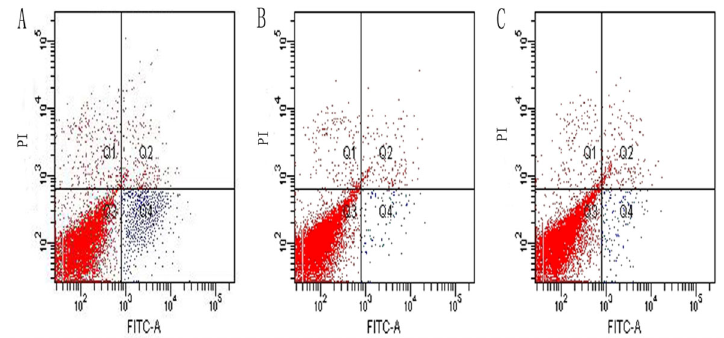
Figure 3. Apoptotic cells can be observed at a specific Q4 of the graphics for groups A, B, and C. Flow cytometry analysis of PDL fibroblasts apoptosis following treatment with AGE-BSA ( A ) and BSA alone ( B ). Group A (11.31±1.73% apoptosis) had significantly more apoptotic cells than the control group ( C ) (1.1±0.38%, P , 0.05). The percentage of apoptotic cells in